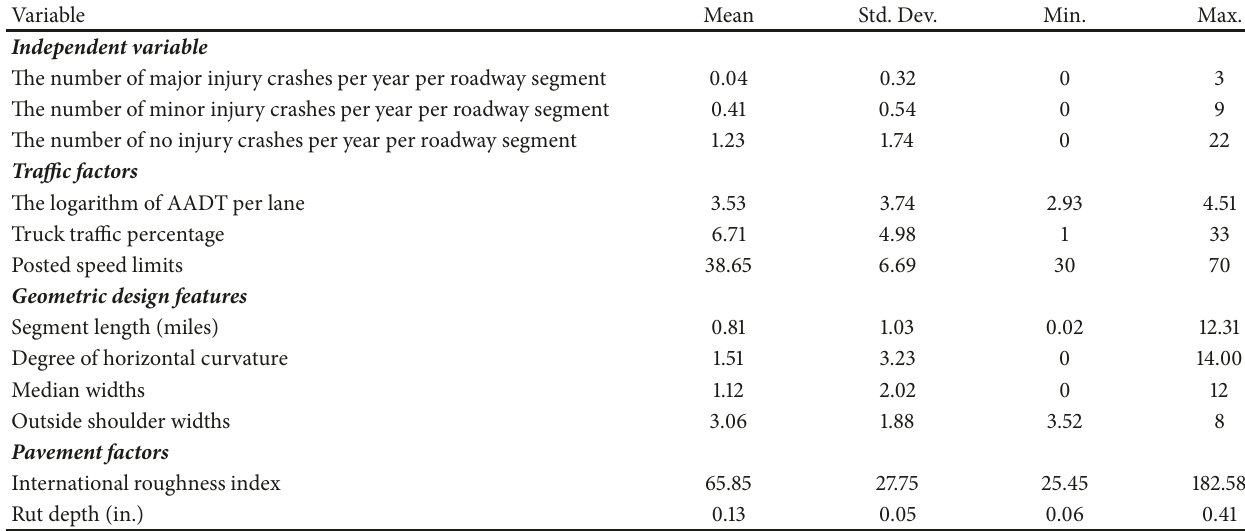
Table 1: Summary statistics of analyzed continuous variables.